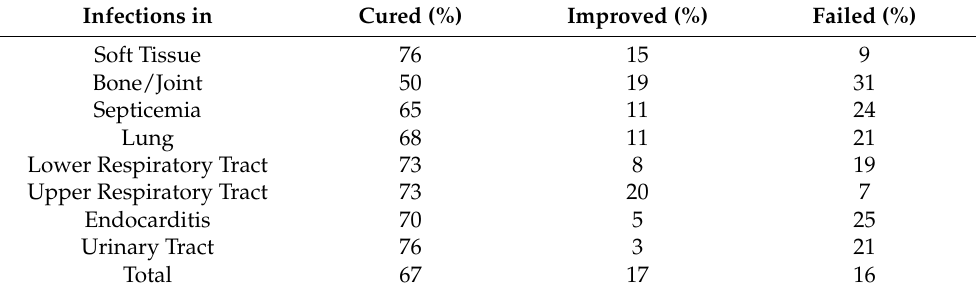
Endocarditis Urinary